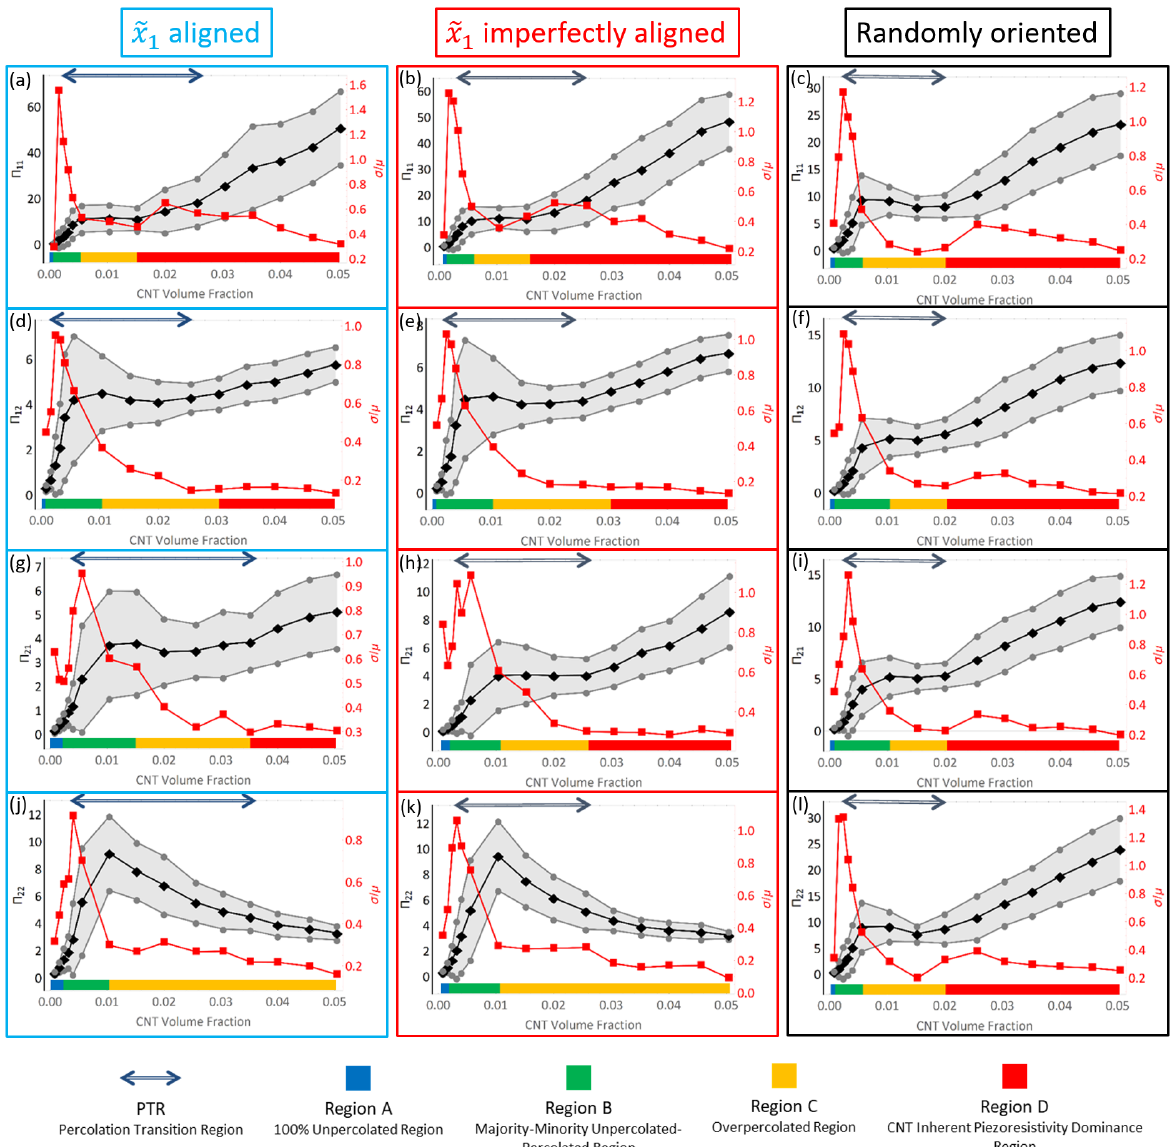
Figure 22. The mean, mean ± standard deviation and coefficient of variation shown in black, grey and red, respectively, for Π 11 , Π 12 , Π 21 and Π 22 for ˜ x 1 aligned, ˜ x 1 imperfectly aligned and randomly oriented cases. Π 11 , Π 12 , Π 21 and Π 22 correspond to the first row ( a – c ), second row ( d – f ), third row ( g – i ) and fourth row ( j – l ), respectively. Regions A, B, C and D along with the PTR are denoted in each